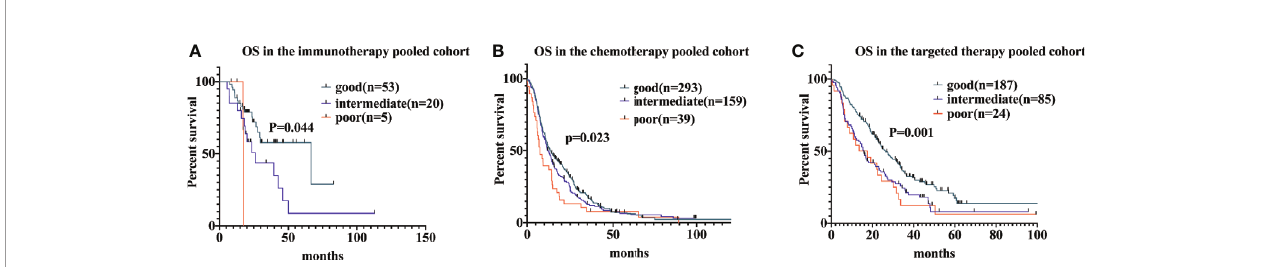
FIGURE 2 | Associations of the lung immune prognostic index (LIPI) score and overall survival (OS) following systemic therapy among non-small cell lung carcinoma (NSCLC) patients. Kaplan-Meier curves of OS, comparing patients receiving immunotherapy, chemotherapy, and targeted therapy, are presented in (A – C)